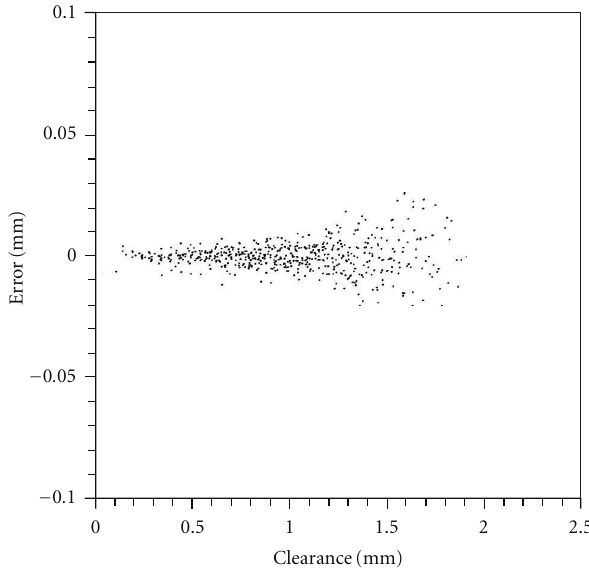
Figure 12: Error in FM capacitance probe measurements plotted against blade number around the spinning rig wheel after compen- sating the error due to shaft eccentricity.